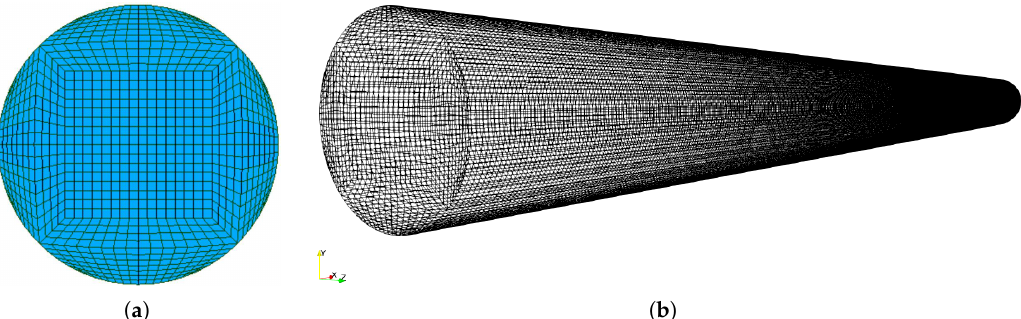
Figure 3. Mesh used in all simulations. ( a ) Cross-sectional and ( b ) perspective